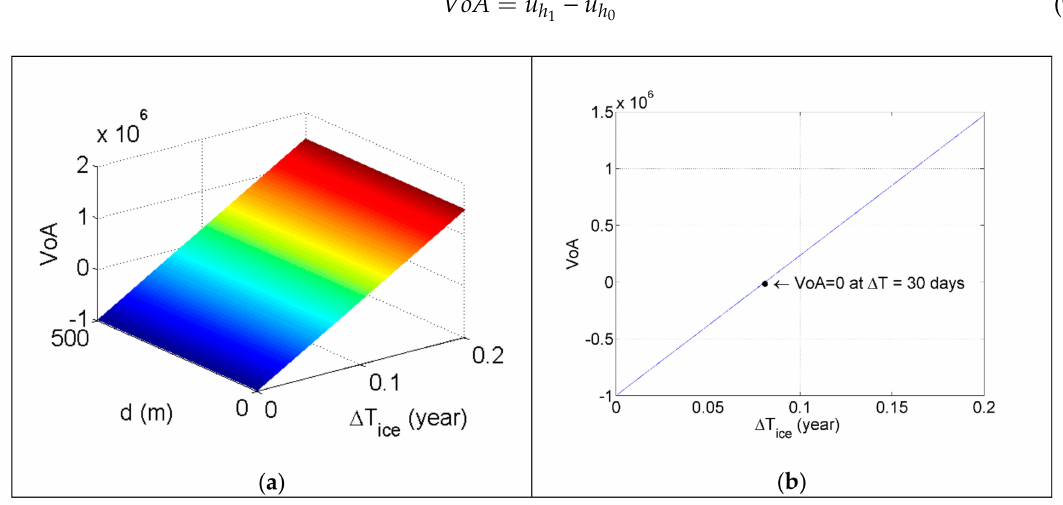
Figure 9. Computational results of VoA in dependence of percentage of downtime per year due to icing ∆ T and distance of wind turbine to a highway d ( a ) and VoA with critical down time point when VoA = 0 ( b